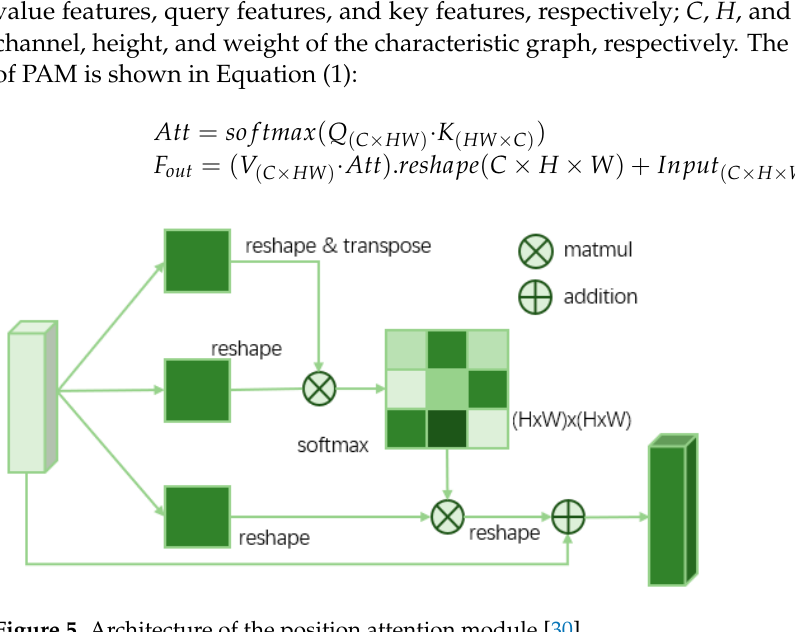
Figure 6. Architecture of the channel attention module [30]. Figure 7. The construction of d-blockplus.